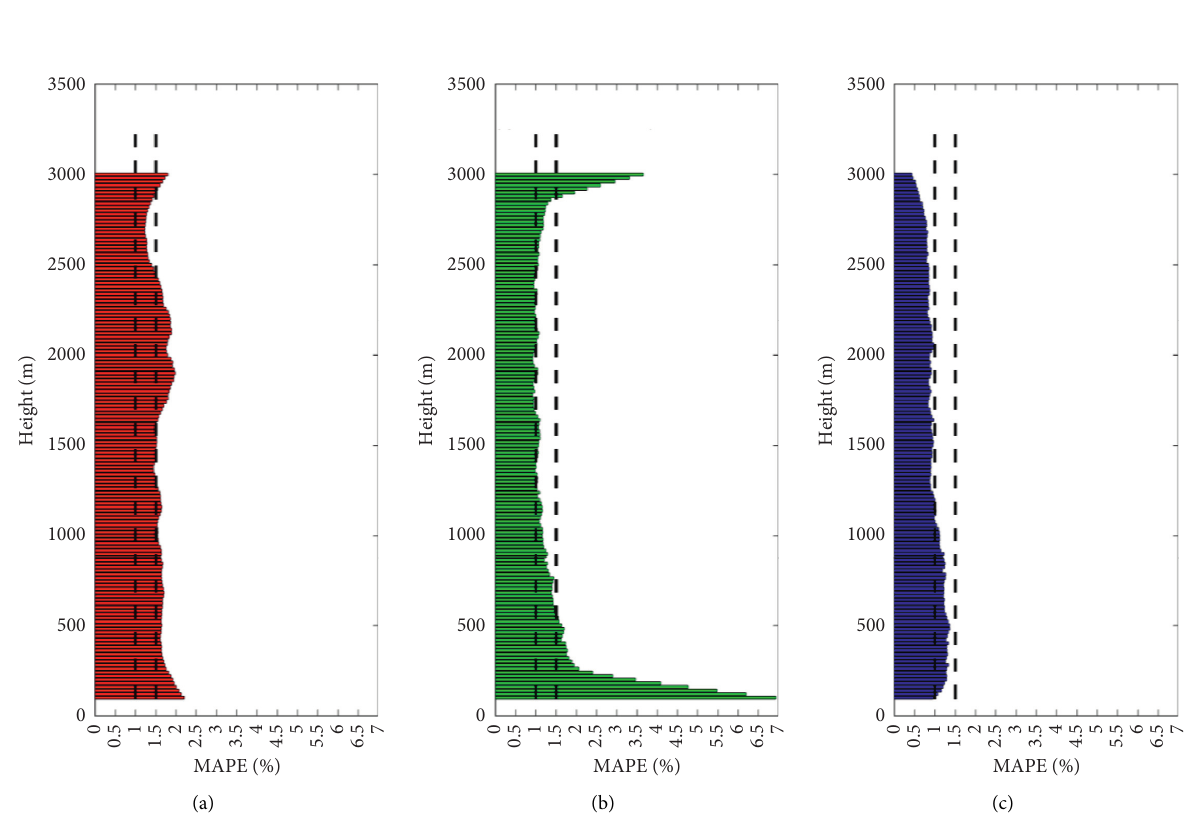
Figure 4: The average MAPE of the three algorithms at each